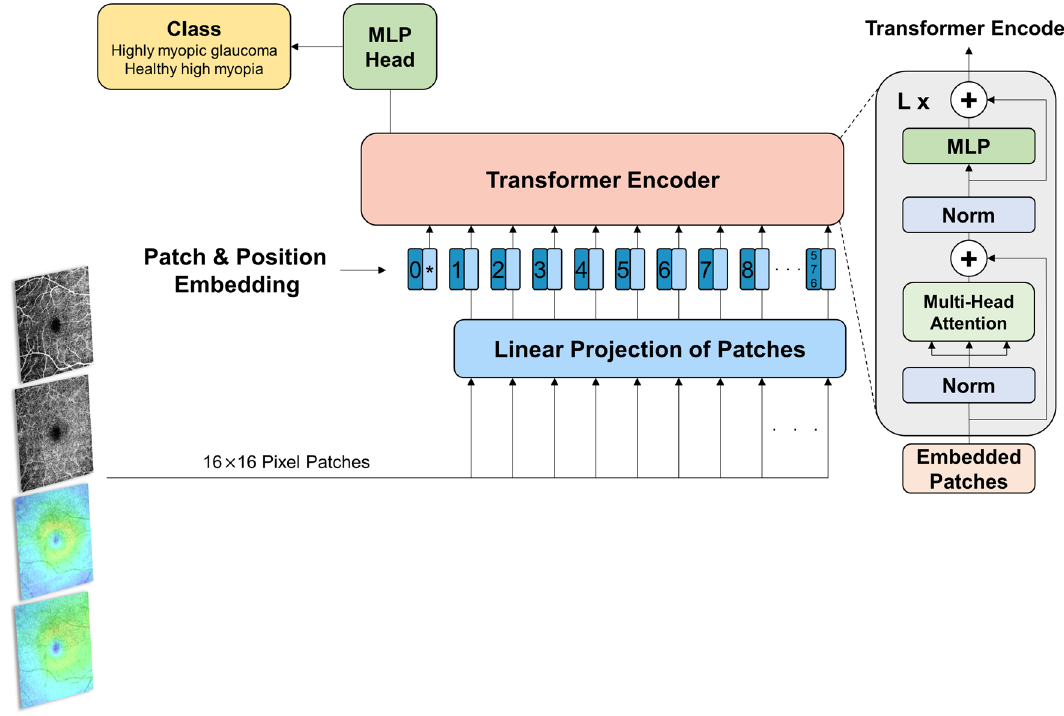
Figure 3. Schematic of Vision Transformer (ViT) model. MLP, multi-layer